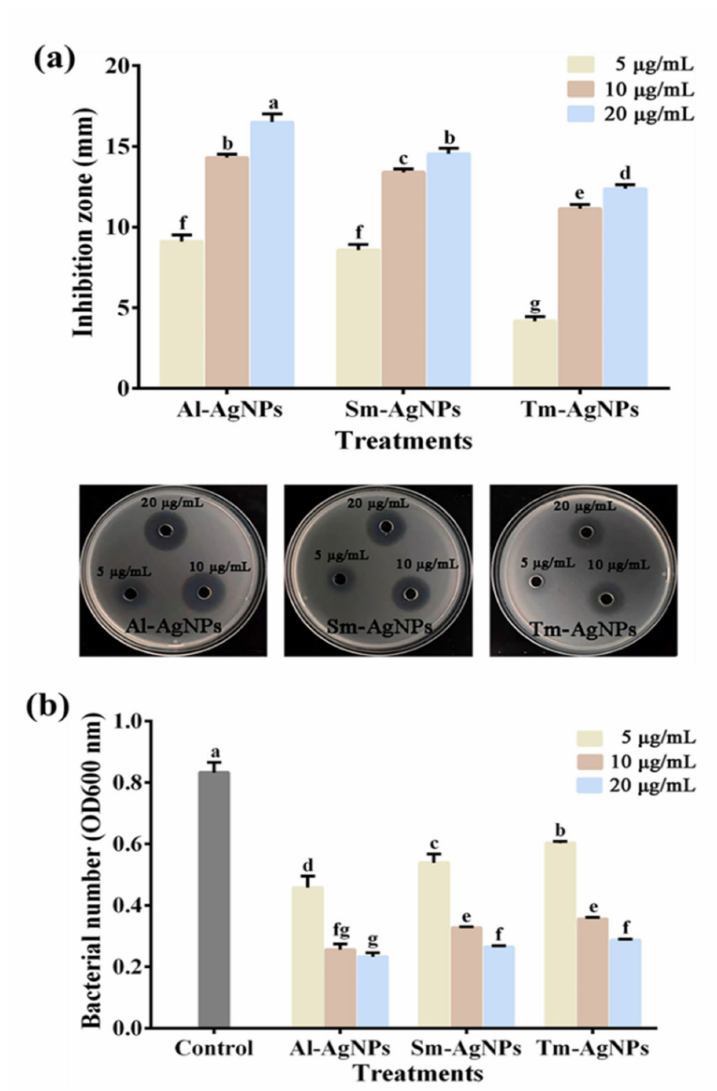
Figure 4. The antibacterial effect of Al-AgNPs, Sm-AgNPs and Tm-AgNPs on Xoo strain C2. ( a ) The inhibition zone of well diffusion assay; ( b ) The in vitro antibacterial activity in liquid broth. Error bars showing the mean of three replicates (n = 3 ± standard deviation). Different lowercase letters on the bars are represent the signifcantly different at p ≤